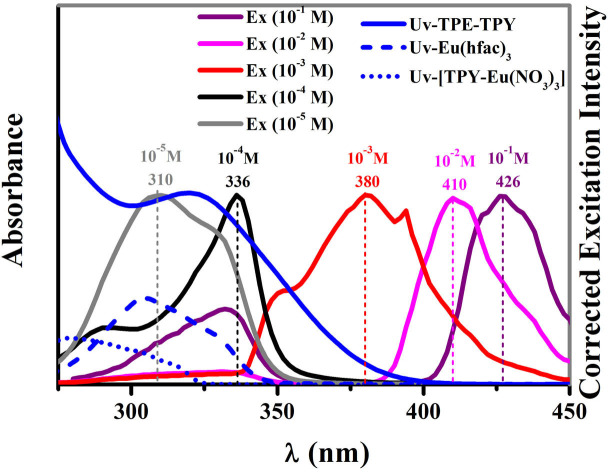
Excitation spectra of 1 (λem = 613 nm) in different concentrations, and absorption spectra of TPE-TPY, Eu(hfac)3·2H2O and [TPY-Eu(hfac)3] in CH2Cl2 with the concentrations of 10−5 M at 298 K.